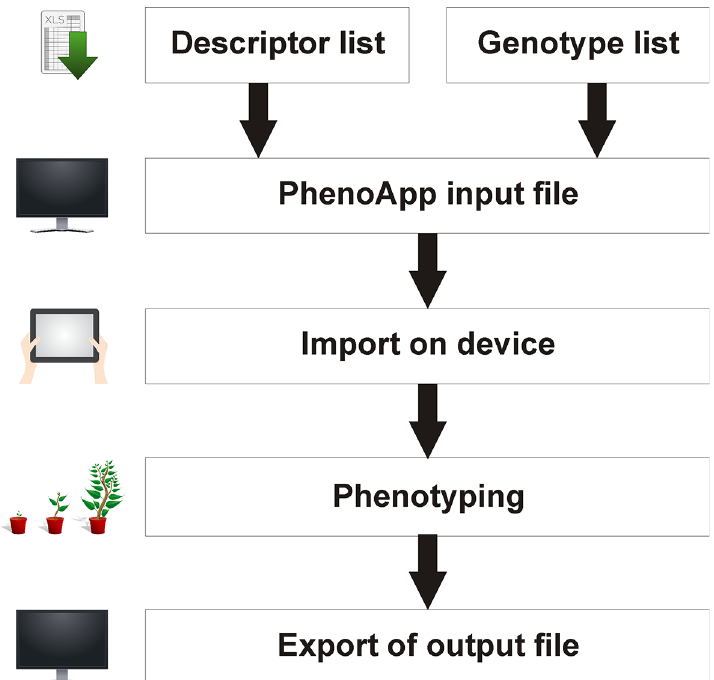
Figure 2. Principal PhenoApp workflow. A combined genotype-location and descriptor list is required as input. Post phenotyping, recorded data can be exported as a simple Microsoft Excel file. Minimal requirements are